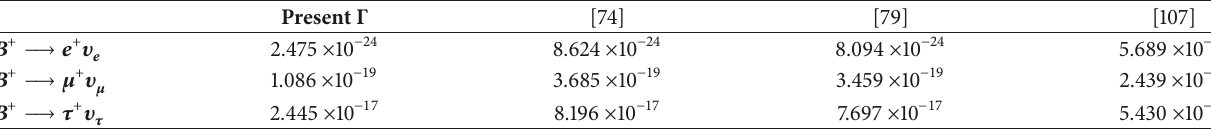
Table 9: Leptonic decay width of B + meson in GeV.